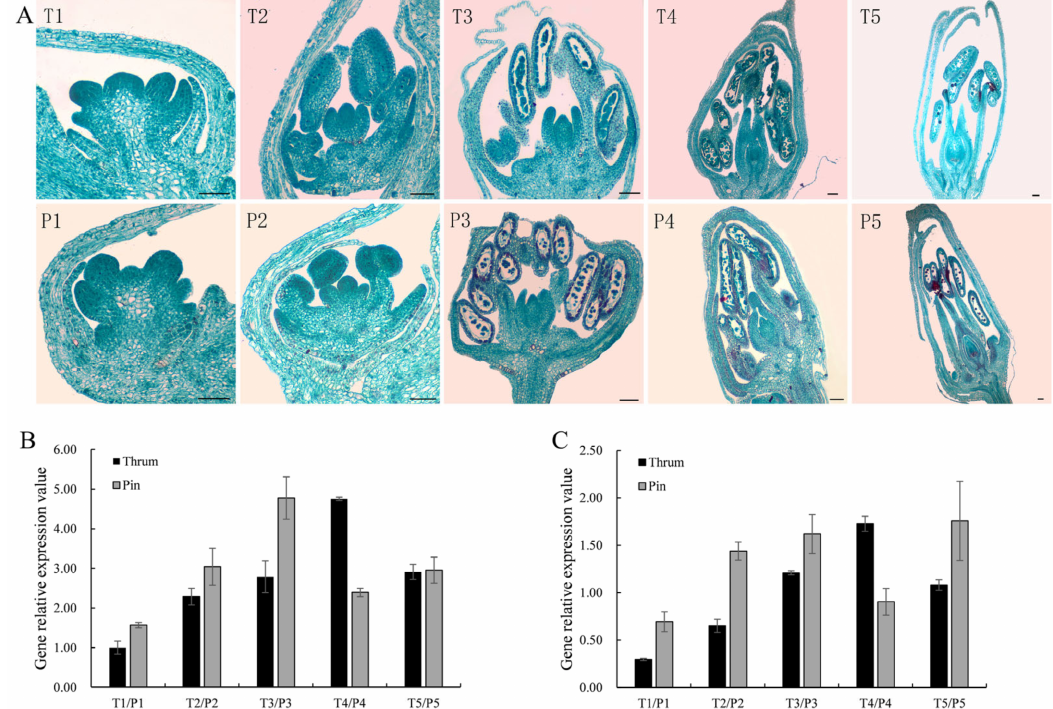
Figure 6. Morphology, FaesAP3_2 and FaesAP3_2a expression in common buckwheat distylous flowers at sequential developmental stages. ( A ) Morphology of thrum and pin flowers at various development stages; T1–T5: morphological differentiation and development of the thrum flower buds; T1: stamen primodium emergence; T2: stamen filament elongation; T3: microspore mother cells meiosis; T4: mononuclear microspore at Periphery, tepal enclosing; T5: full maturity flower buds with mature pollen and embryo sac before anthesis; P1–P5: morphological differentiation and development of the pin flower buds; P1: stamen primodium appearance; P2: stamen filament rapid elongating; P3: microspore mother cells meiosis and formation of microspores tetrads; P4: microspore released from tetrads and tepal enclosing; P5: full maturity flower bud with mature pollen and embryo sac before anthesis; ( B ) FaesAP3_2 expression at sequential development stages of thrum and pin flower buds were detected by qRT-PCR, respectively; ( C ) FaesAP3_2a expression at sequential development stages of thrum and pin flower buds were detected by qRT-PCR, respectively; scale bar: 100 µ